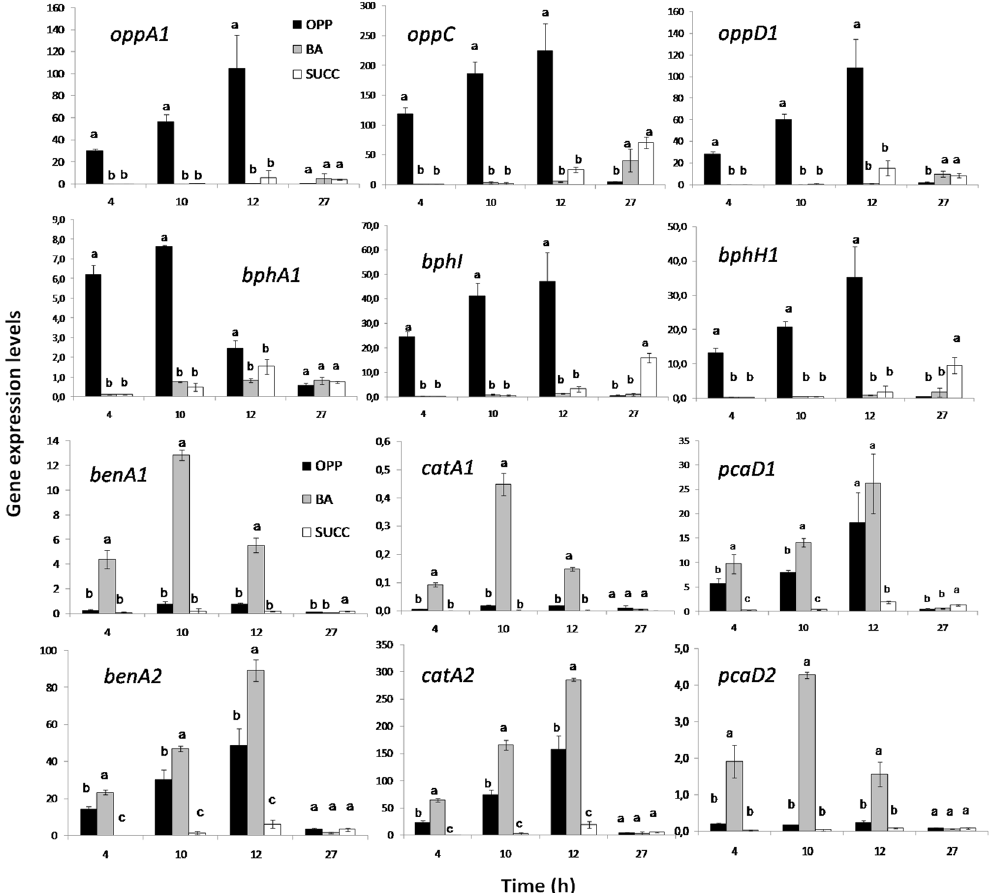
Figure 4. The transcription patterns of selected genes involved in the upper metabolic pathway of ortho - phenylphenol (OPP) ( oppA1, oppC, oppD1 ), in the upper and lower bph pathway ( bphA1,bphI, bphH1 ) and in the ortho cleavage of benzoic acid (BA) ( ben/cat pathway) by Sphingomonas haloaromaticamans strain P3 growing on MSM + CA + OPP, + BA or + Succinate (Succ). Within each time point bars designated by the same letter are not significantly different at the 5% level. The transcription patterns of the remaining catabolic genes are given in Supplementary Figs